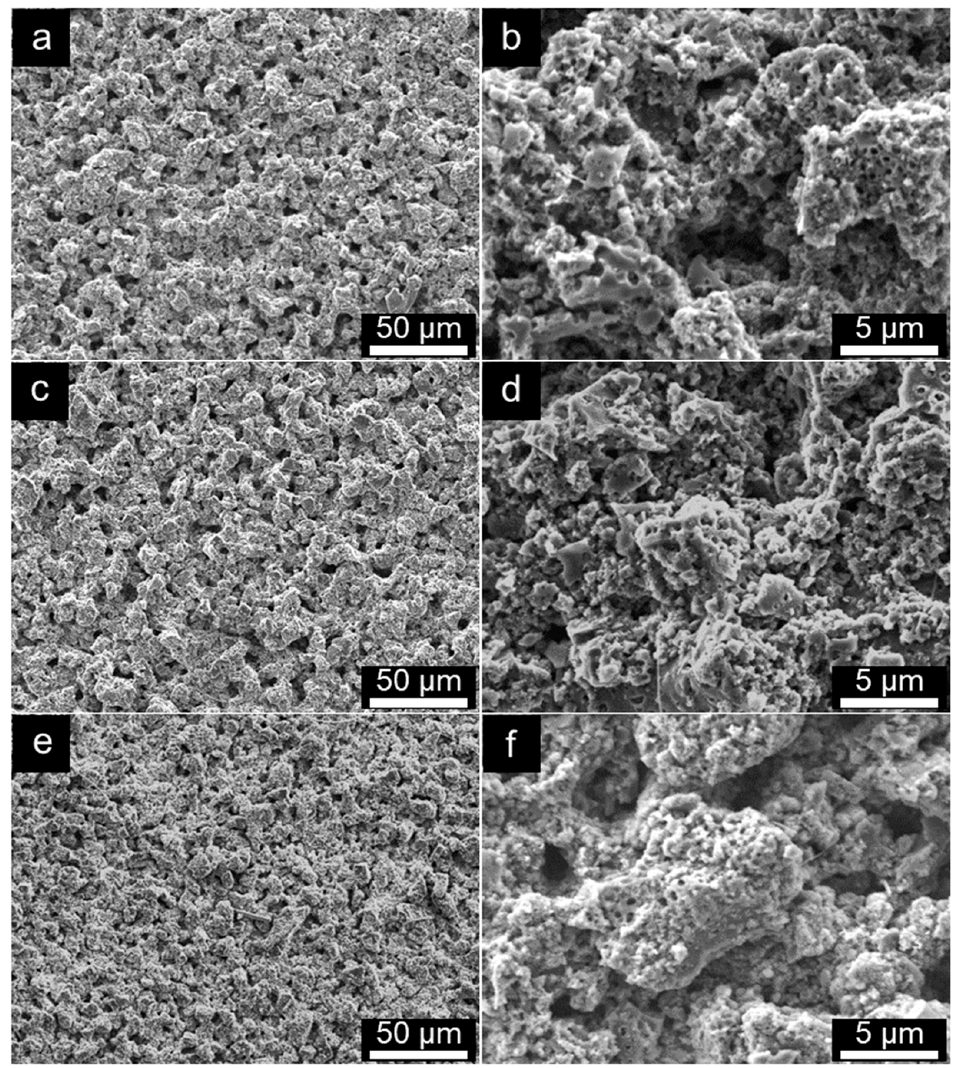
Figure 10. SEM images of Alg ‐ C electrodes. ( a,b ) Fresh electrode; ( c,d ) after the 100th cycle; ( e,f ) after the 5000th cycle at a current density of 500 mA g ‐ 1 between the potential window from 0.02 to 3.0 V.